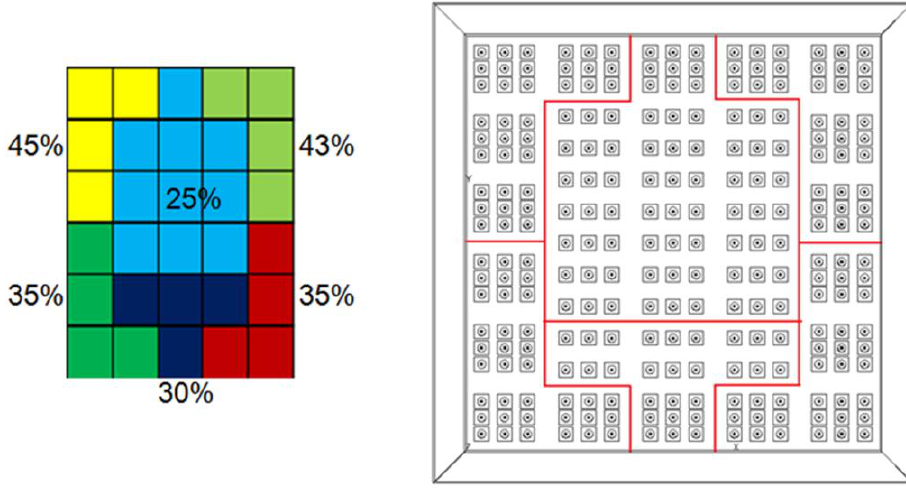
Figure 26. LED power distribution: type 2.